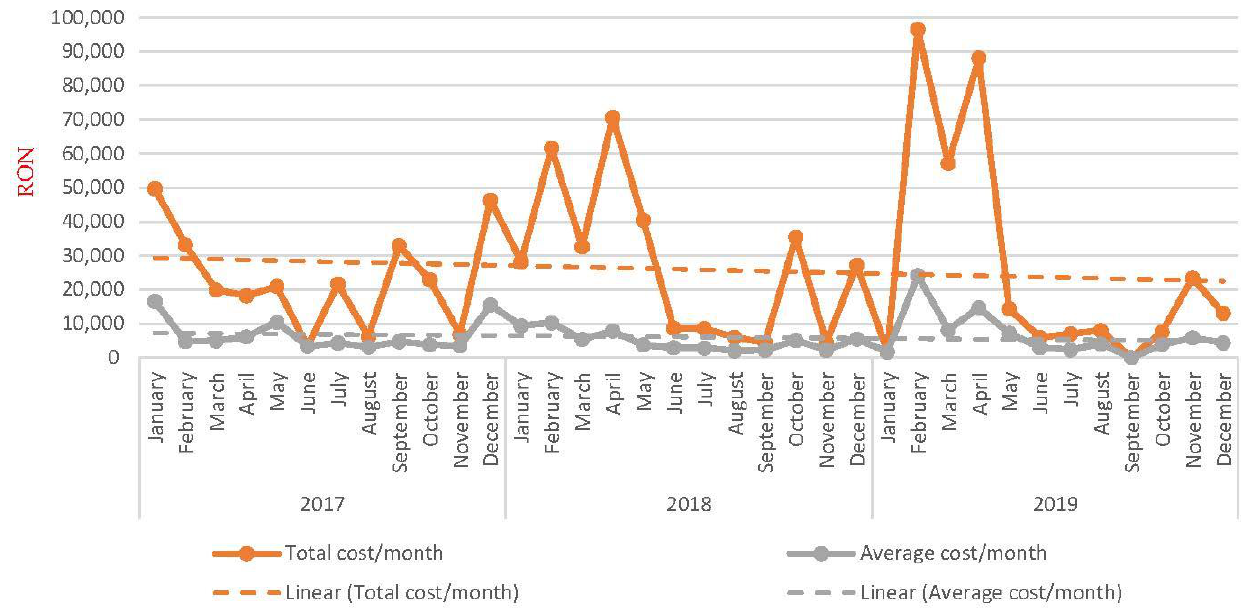
Figure 3. Chronogram, seasonality, and linear trend for total cost per month and average cost per month.